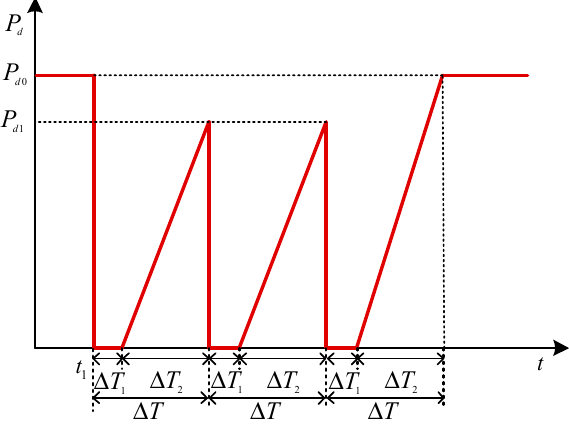
Figure 1. Transmitted power of DC inverter under continuous commutation failures (CFs).